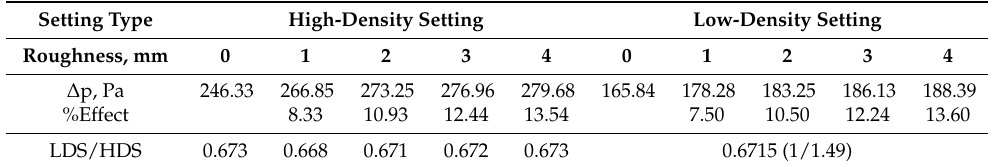
Table 5. Pressure drops across the entire setting for different kiln boundary surface roughness